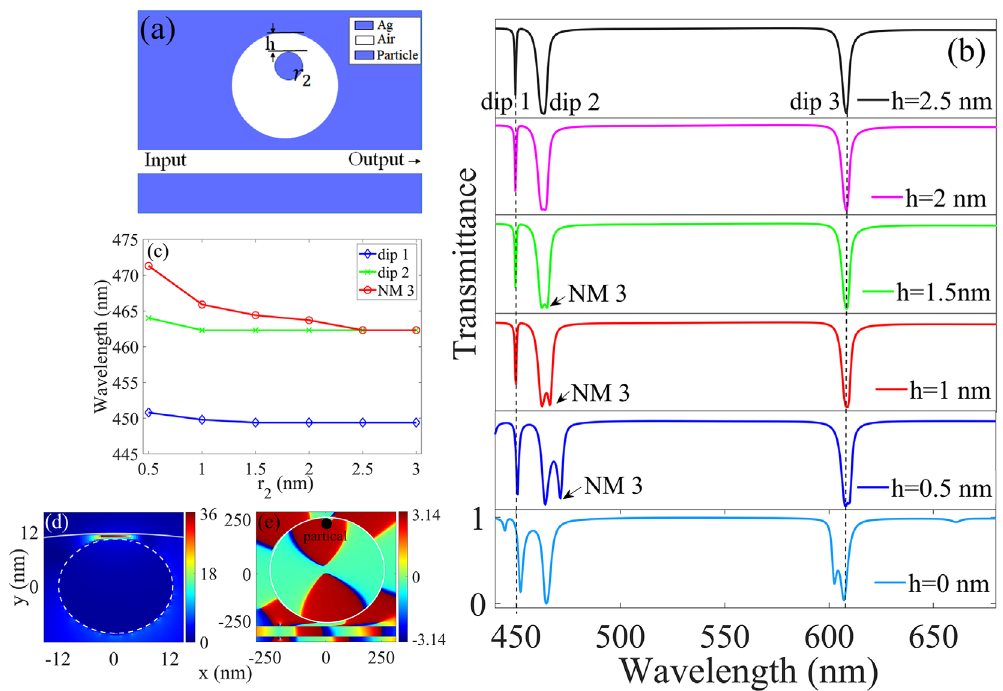
Figure 5. Resonances with a particle deviating from the inwall of cavity. ( a ) Structure. ( b ) Spectra for different spaces. ( c ) Mode variations with space (h). For dip NM 3 centered at 466.3 nm, ( d ) near-field module and ( e ) the phase distribution of E y